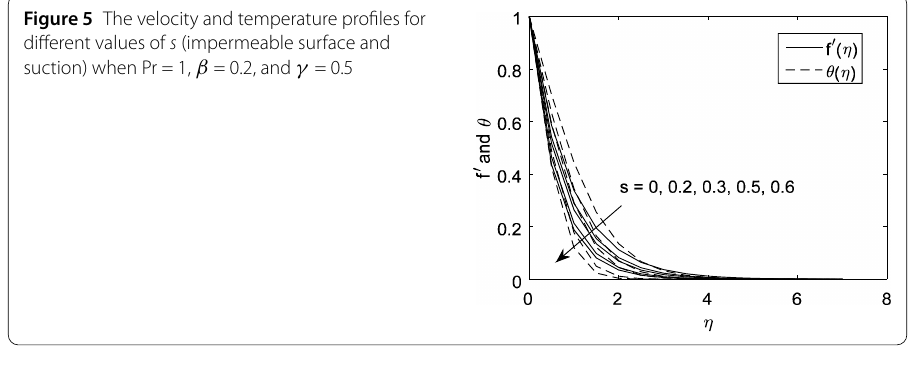
Figure 6 The velocity and temperature profiles for different values of s (injection) when Pr = 1, β = 0.2, and γ =